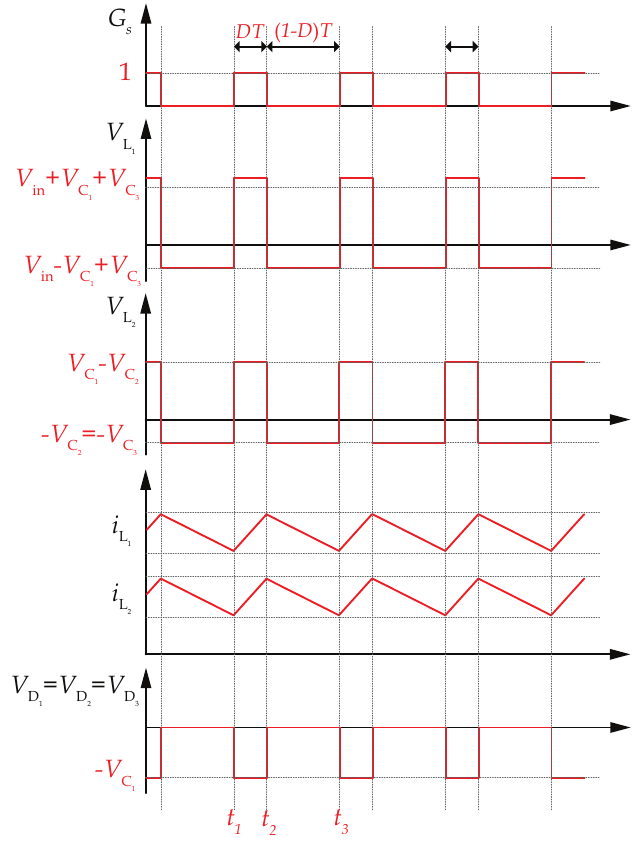
Figure 6. Steady-state waveforms of the proposed S-qZSI. Table 1. Voltage of the components in shoot-through and non-shoot-through modes. Voltage Components Shoot-Through Mode Non-Shoot-Through